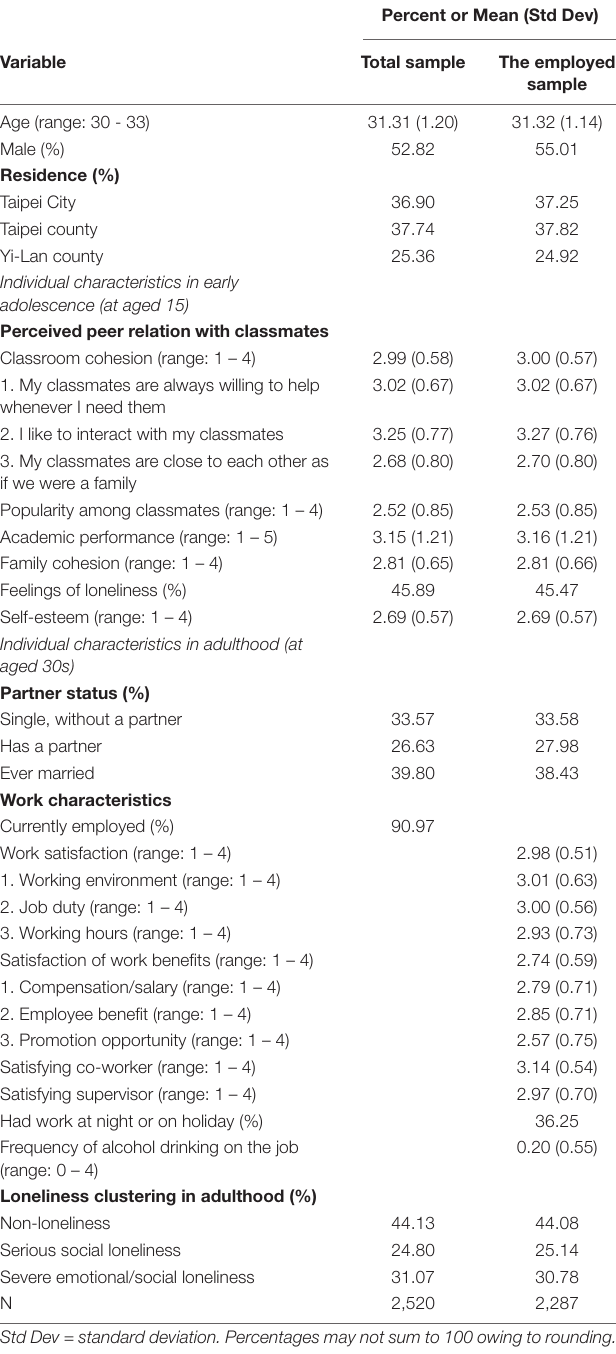
TABLE 1 | Descriptive characteristics of the total sample and the employed sample of young adults used in this study [percent or mean (Std Dev)], Taiwanese Youth